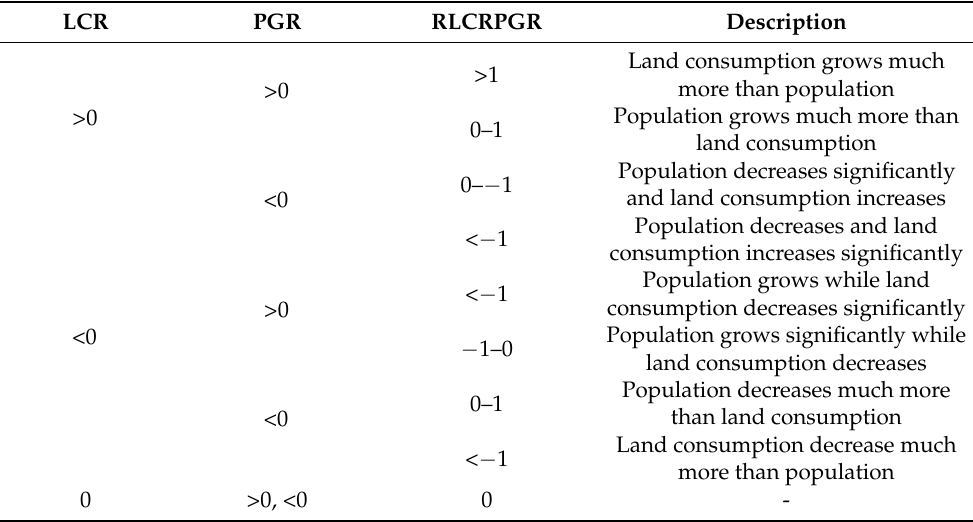
Table 2. Interpretation of the RLCRPGR based on the values of the two terms LCR (Land Consump- tion Rate) and PGR (Population Growth